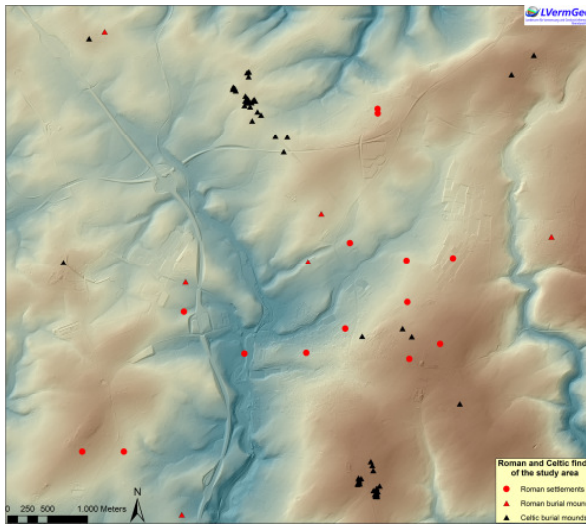
Figure 2. Distribution of finds in the study area